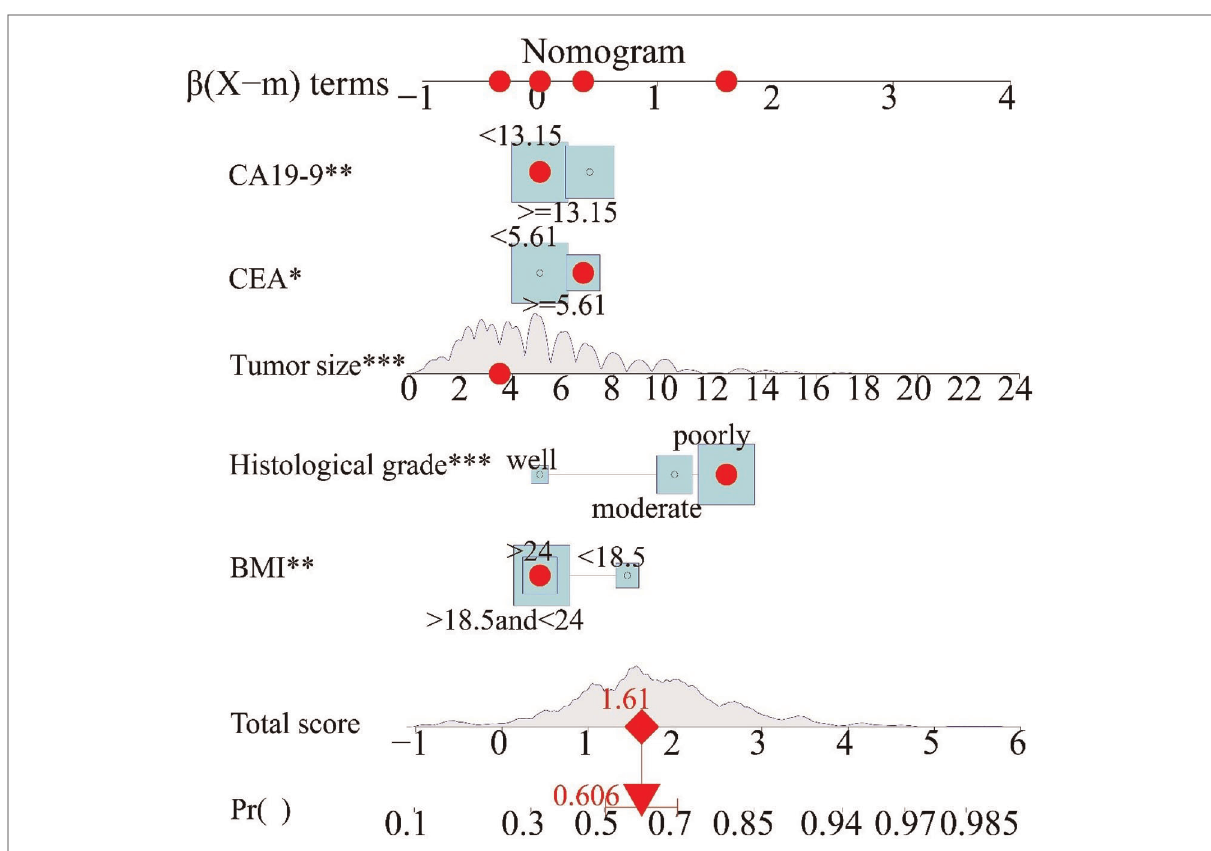
FIGURE 3 Clinical interactive application. The red points on the fi ve axes of BMI, histological grade, tumor size, CEA, and CA19-9 represent individual patient independent variable scores, which were selected by the results of the preoperative examination. The red dot on the total score represents the total score of the individual patient ’ s LNM risk, and the downward red arrow represents the probability of a speci fi c LNM for that score. BMI, body mass index; CEA, carcinoembryonic antigen; CA19-9, cancer